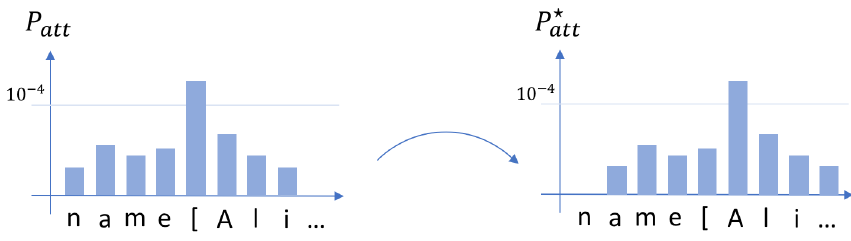
Figure 2. An example of the shift trick.